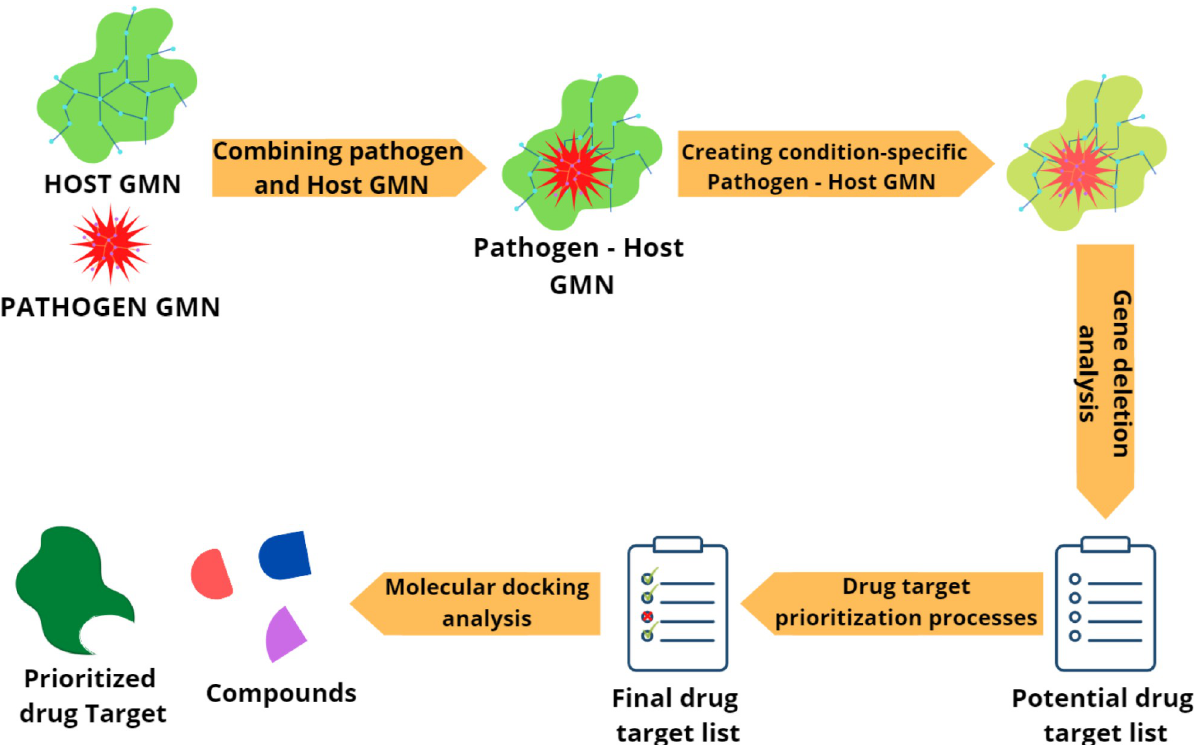
Fig 4. The flowchart of the pipeline followed in this